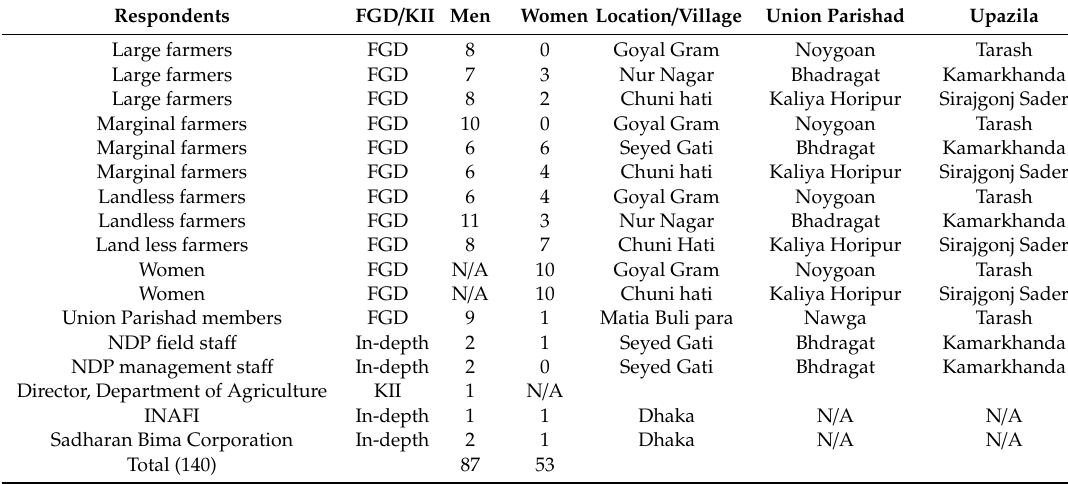
Table 1. Dialogs held in Sirajganj, Bangladesh (2017).